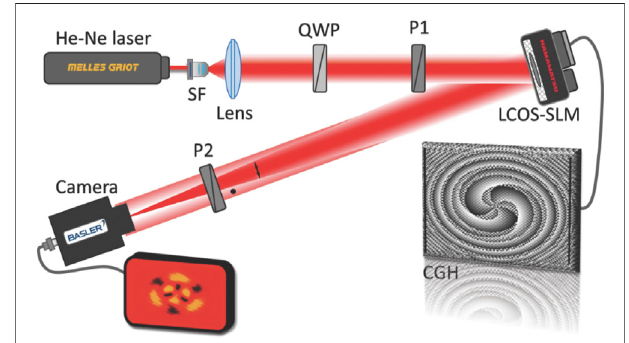
FIGURE 1 | Scheme of the optical system. SF: spatial fi lter; QWP: quarter-wave plate; P: linear polarizer; CGH: displayed phase-only computer- generated